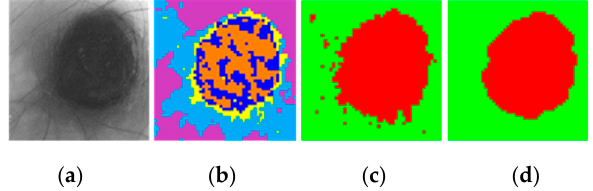
Figure 8. HS dermatologic segmentation example. ( a ) Gray-scale image. ( b) Segmentation map using five clusters (colors are randomly assigned). ( c ) Two-class segmentation map obtained after comparing the five centroids with the reference library using the SAM algorithm (red indicates PSL and green normal skin). ( d ) Two-class segmentation map after applying morphological closing operation.